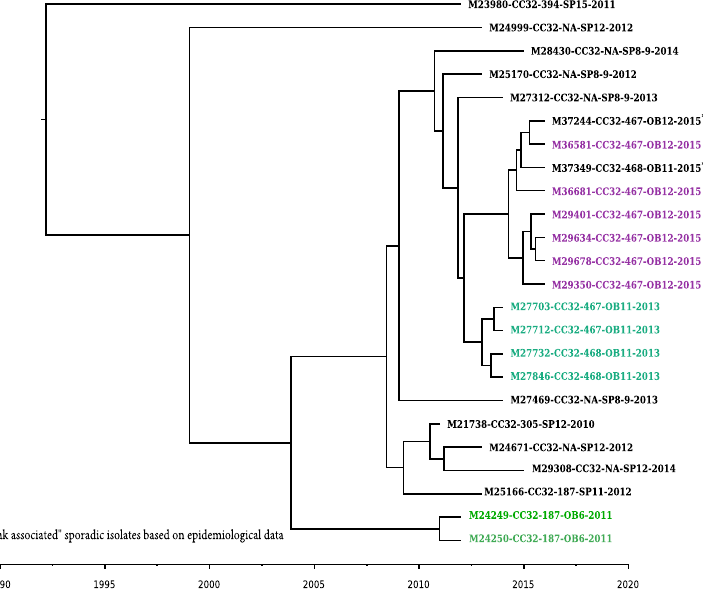
Figure 3. Timed phylogenetic tree of NmB CC32 outbreak and sporadic isolates. A time-dependent phylogenetic reconstruction of the NmB CC32 outbreak and sporadic isolates, inferred by Bayesian inference using BEAST. The NmB CC32 consisted of 24 isolates from 3 outbreaks (OB6, OB11, and OB12), along with the geographically matched sporadic isolates. Geographically matched sporadic and outbreak isolates have the same number following “SP” or “OB” in label. Isolate label contains isolate ID, CC, PFGE pattern, outbreak or sporadic isolates, and year. Each colored branch and isolate label represents a different